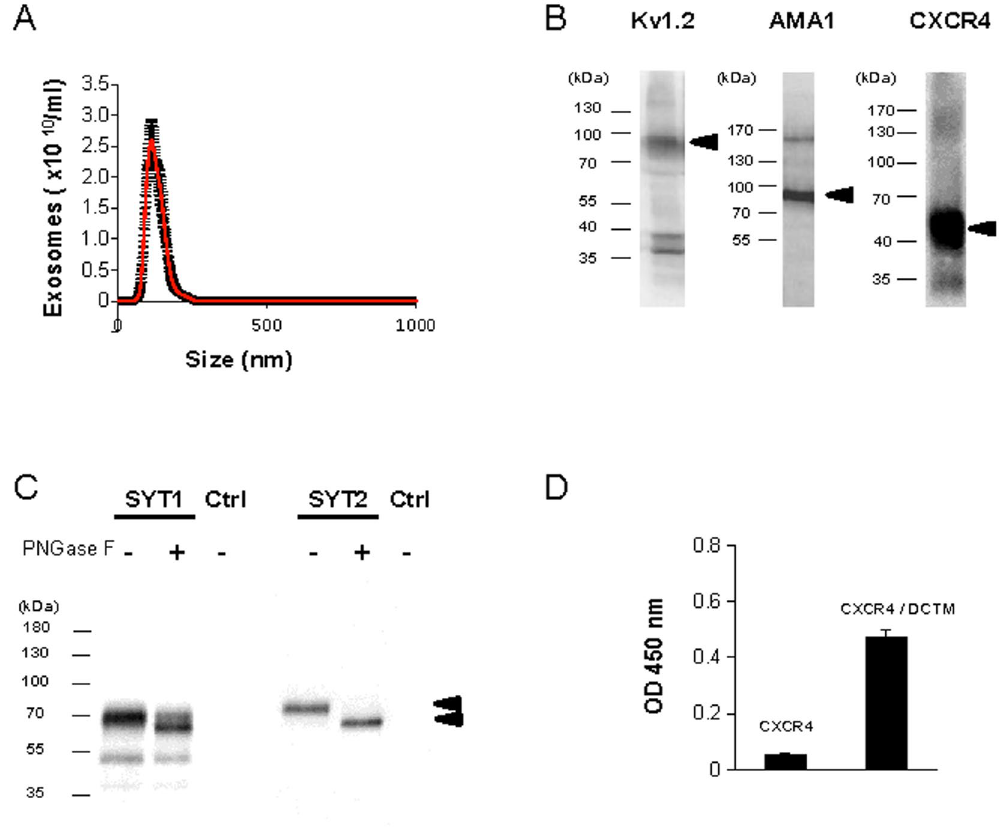
Figure 1. Expression of recombinant membrane proteins in exosomes. ( A ) Nanoparticle tracking analysis of purified exosomes yielded a mean size of SYT2-expressing exosomes of 127 ± 30 nm (mean of 5 independent determinations). ( B ) Kv1.2, AMA1 and CXCR4 exosomal preparations were analyzed by Western blot using specific antibodies. Arrowheads indicate expected molecular weight. ( C ) ExoSYT1 and 2 were treated in the presence or absence of PNGase F and analyzed by Western blot using anti-SYT antibody (1D12). Exocontrol from non-transfected cells were used as a control (Ctrl). ( D ) Expression levels of CXCR4 in exosomal preparations with or without the presence of the DCTM peptide tag. The nonspecific signal has been subtracted. Error bars are SD from triplicates. Representative of 3 experiments using 2 independent exosomes preparations.